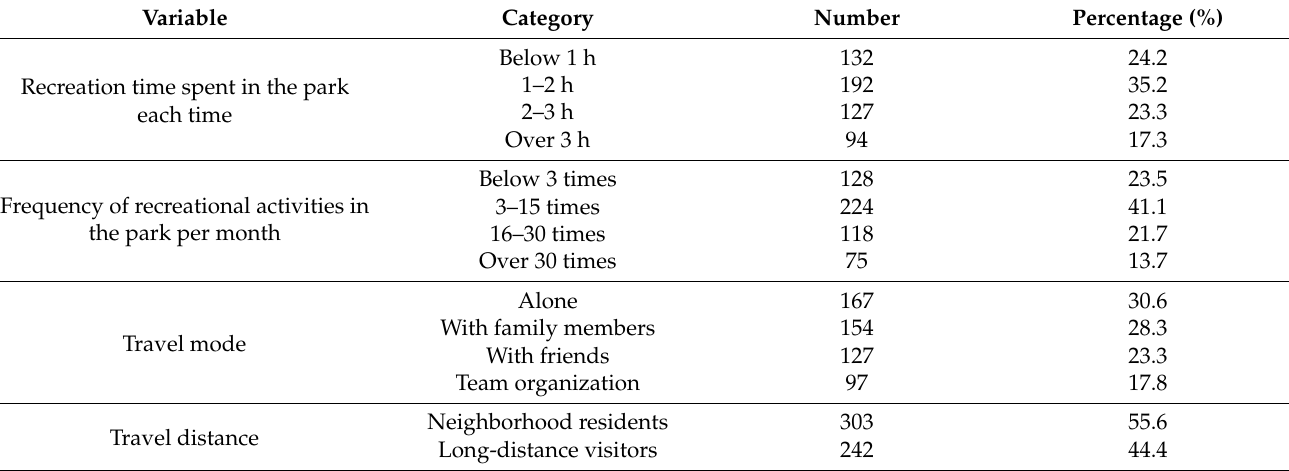
Table 2. Recreation behavior characteristics of respondents (N =